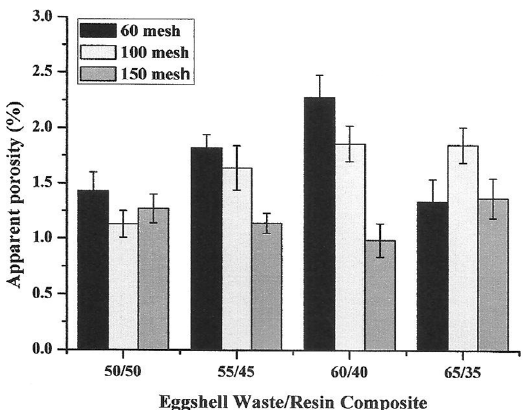
Figure 9. Apparent porosity of the cured artificial rock specimens.